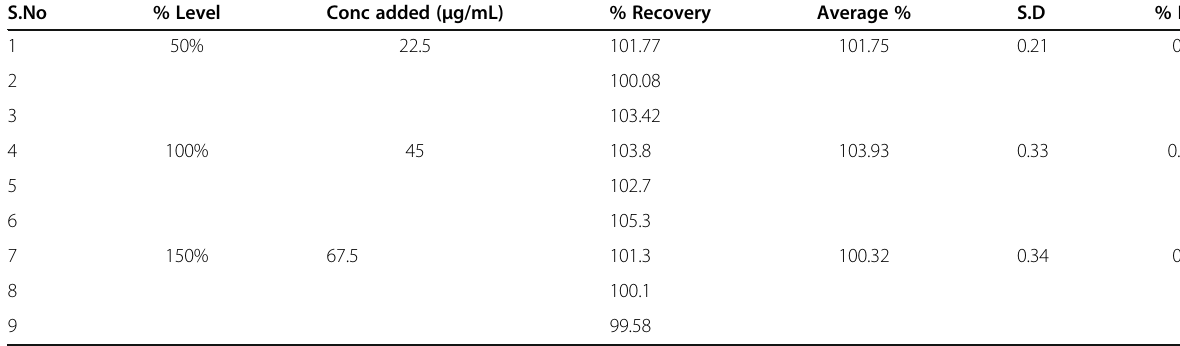
Table 8 %Recovery of Ivacaftor in mobile phase S.No